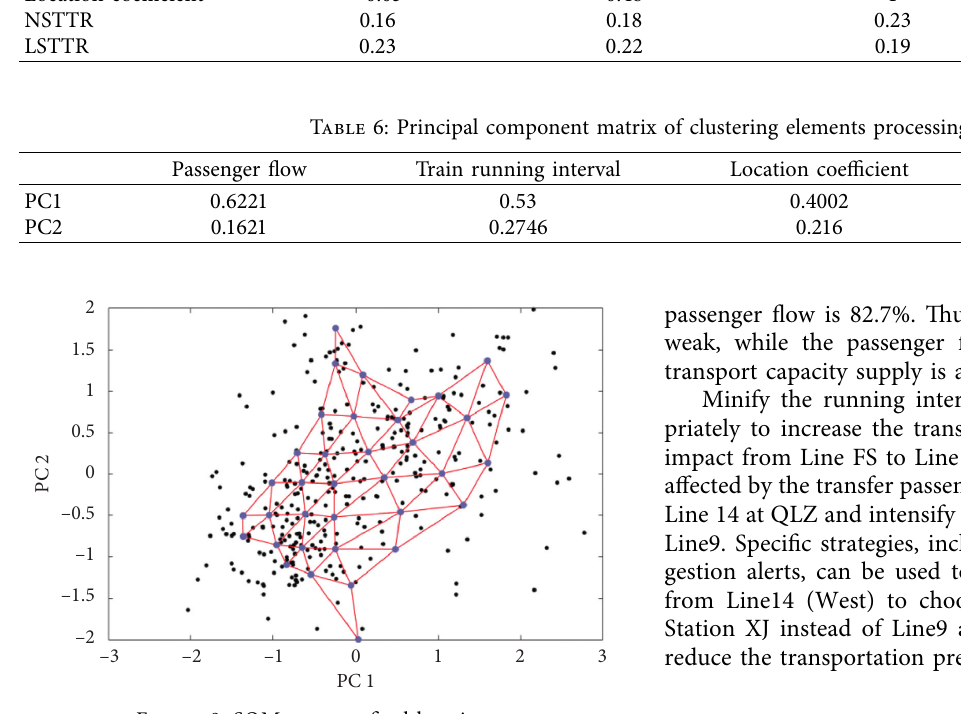
Figure 9: SOM neurons final